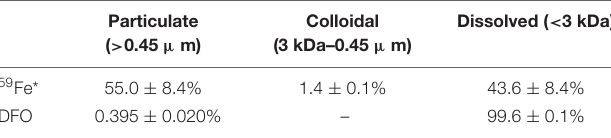
TABLE 1 | Partitioning of 59 Fe and DFO among suspended particles/aggregates (0.45 µ m), colloids (3–0.45 µ m), and dissolved phase ( < 3 kDa) after the incubation in northern Gulf of Mexico